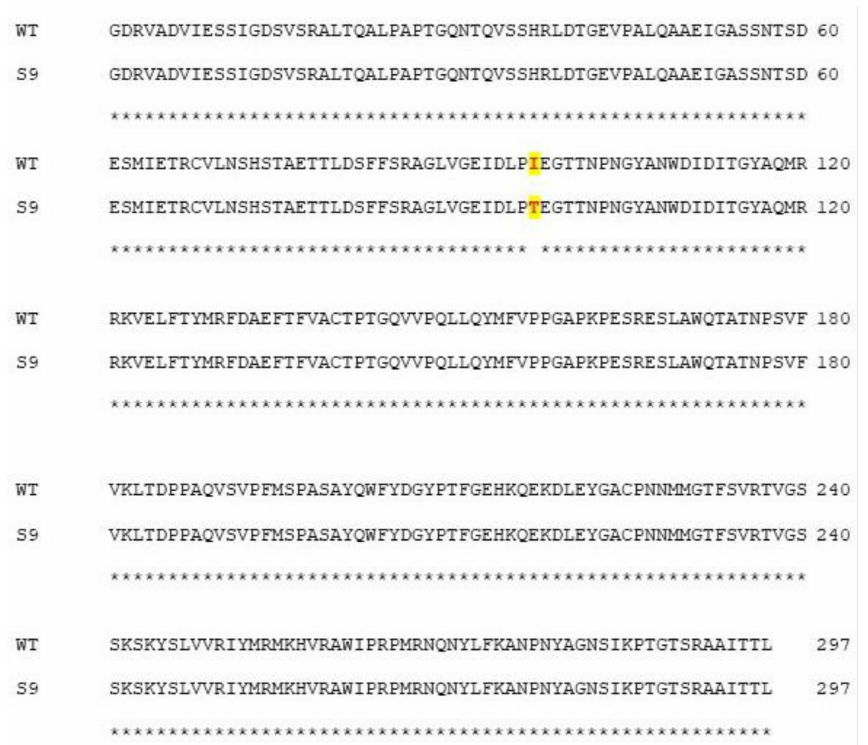
Figure 6. Sequence alignment analysis of wild type (WT) and silymarin-resistant mutant (S9) by Clustal Omega 1.2.4. The amino acid mutation from isoleucine (I) in wild type to threonine (T) in the silymarin-resistant mutant is